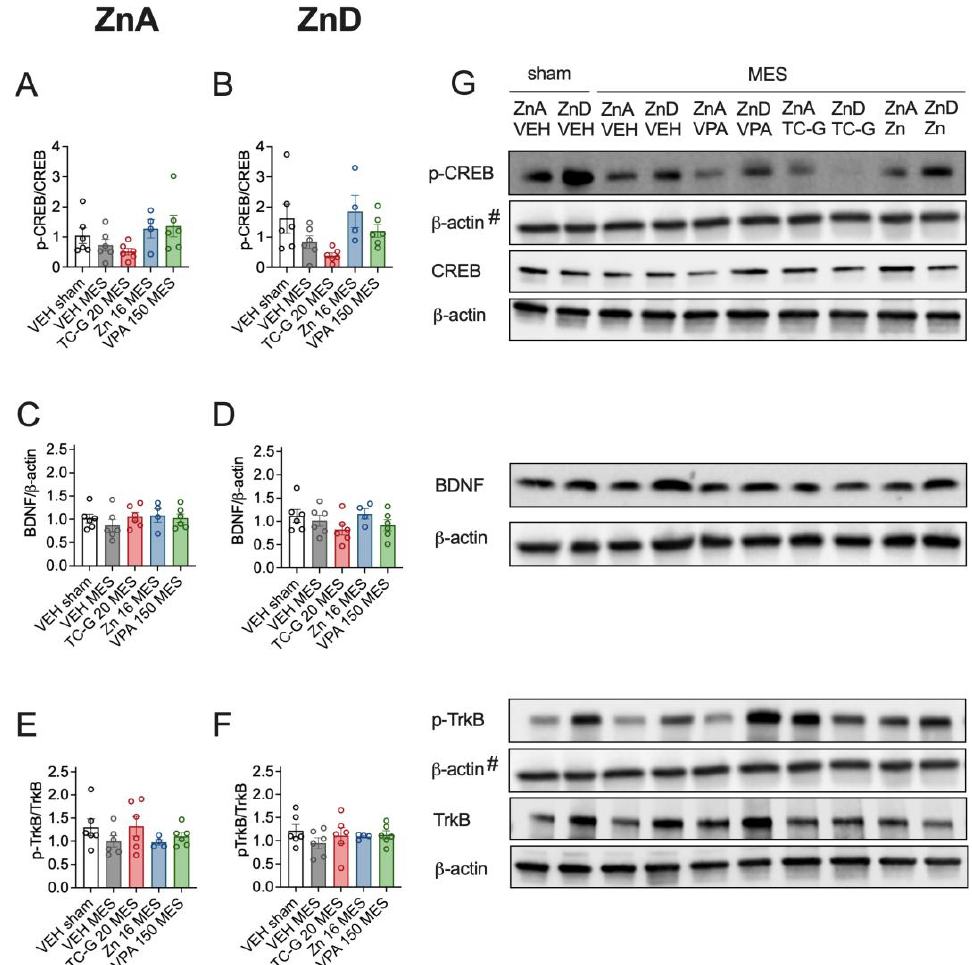
Figure 3. Acute effects of TC-G 1008 (TC-G) (20 mg/kg), ZnCl 2 (16 mg Zn/kg), or VPA (150 mg/kg) and MES seizures on the relative expression of proteins: phosphorylated CREB (p-CREB), total CREB, BDNF, phosphorylated TrkB (p-TrkB) and TrkB in the hippocampi of mice fed the ZnA or ZnD diet. Hippocampal samples were obtained ca. 3 min after MES. ( A – F ) Data are expressed as means ± SEM of p-CREB/CREB or BDNF/ β -actin or p-TrkB/TrkB ratio. They were analyzed by one-way ANOVA. n = 4 – 6 in each group. Statistical details: ( A ) F(4,23) = 1.100, p = 0.3805, ( B ) F(4,23) = 0.6353, p = 0.6425, ( C ) F(4,23) = 0.5934, p = 0.6709, ( D ) F(4,23) = 1.218, p = 0.3306, ( E ) F(4,23) = 1.100, p = 0.3805, ( F ) F(4,23) = 0.6353, p = 0.6425 (A-F one-way ANOVA). ( G ) Representative blots of p -CREB (Ser 133), CREB (~46 kDa), BDNF (~14 kDa), p -TrkB (Tyr 816), TrkB (~140 kDa) and β -actin (~42 kDa) in the hippocampi of mice. # p-CREB and p-TrkB come from the same blot, thus sharing the corresponding β -actin